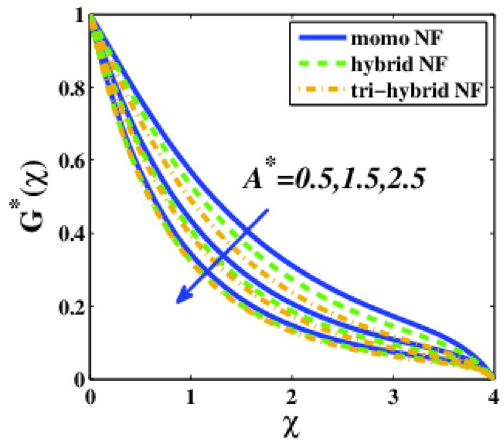
Figure 25. Impression of A ∗ on G ∗ (χ) .